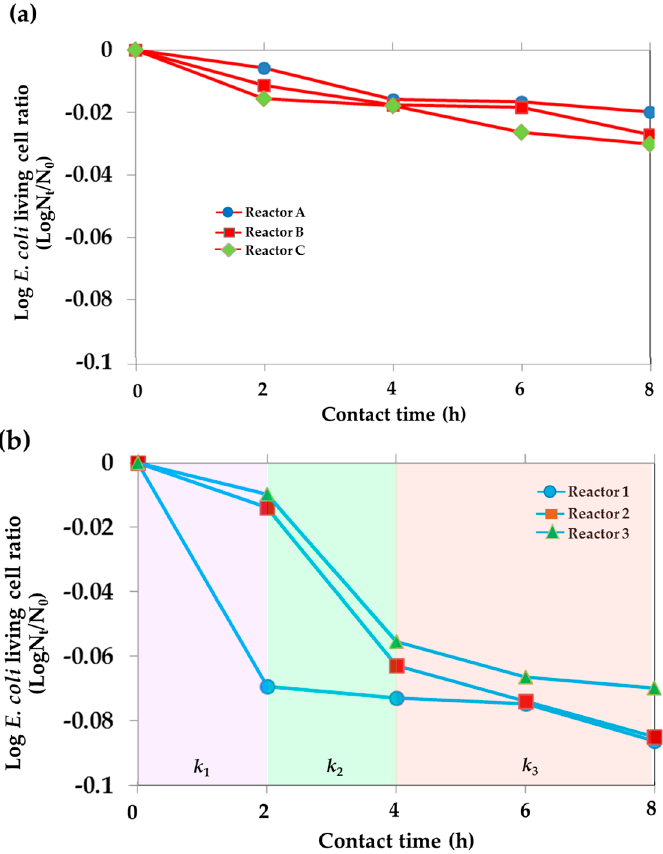
Figure 6. Kinetic data plots of E. coli inactivation for ( a ) Reactors A, B, and C and ( b ) Reactors 1, 2, and 3.